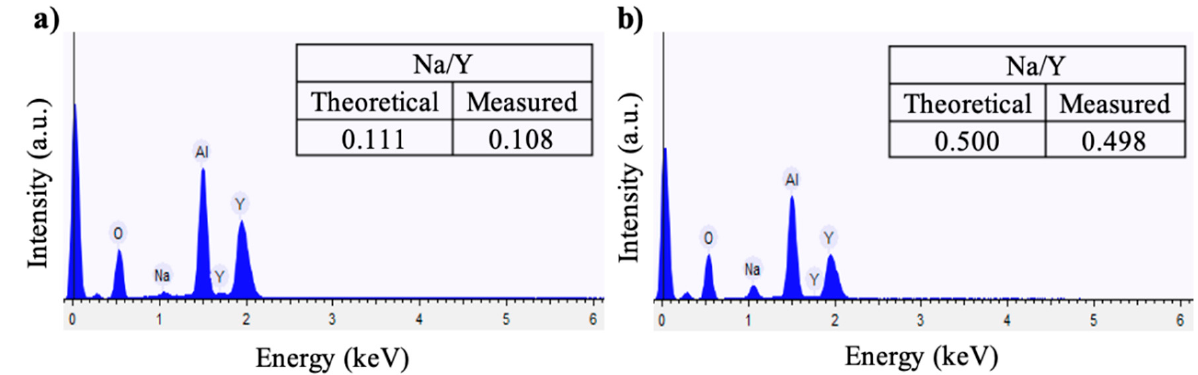
Figure 4. EDX analysis spectra of Y 2.7 Na 0.3 Al 5 O 12 ( a ) and Y 2 Na 1 Al 5 O 12 ( b ) samples.